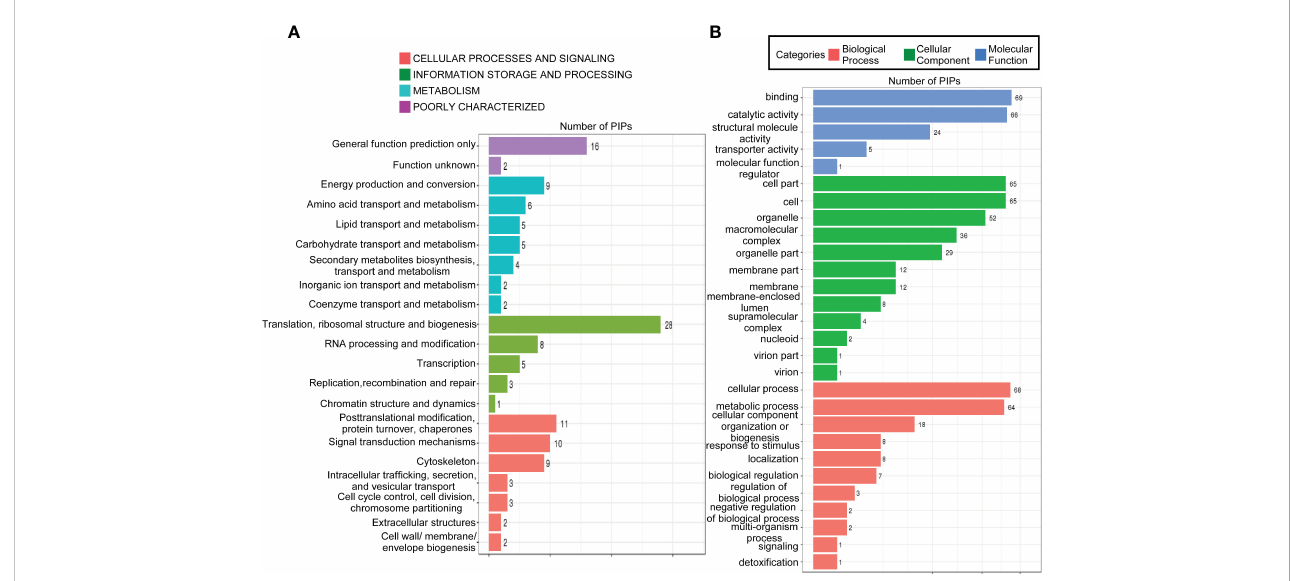
FIGURE 9 Functional analysis of potential interacting proteins of MoPdx1 in M. oryzae . (A) KOG analysis of potential interaction proteins (PIPs) of MoPdx1. The Y- axis represents the analysis categories, including cellular processes and signaling, information storage and processing, metabolism, and poorly characterized. The X-axis represents the number of PIPs. (B) GO analysis of PIPs of MoPdx1. The Y-axis represents the analysis categories, including biological process, molecular function, and cellular component. The X-axis represents the number of PIPs.